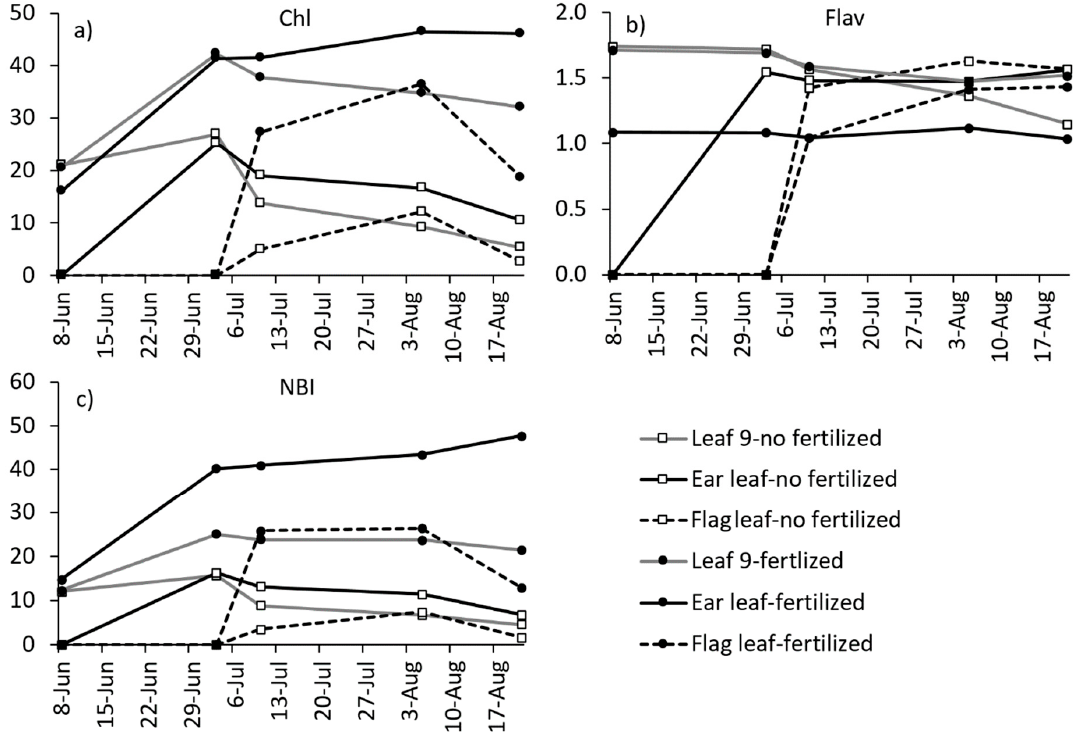
Figure 3. The average measurements (N=6) obtained with Dualex (dimensionless) at different leaves (9, 14-ear and 20-flag) along the maize growing season for: ( a ) the chlorophyll index (Chl), ( b ) the flavonol index (Flav) and ( c ) the N balance index (NBI) at two N rates.